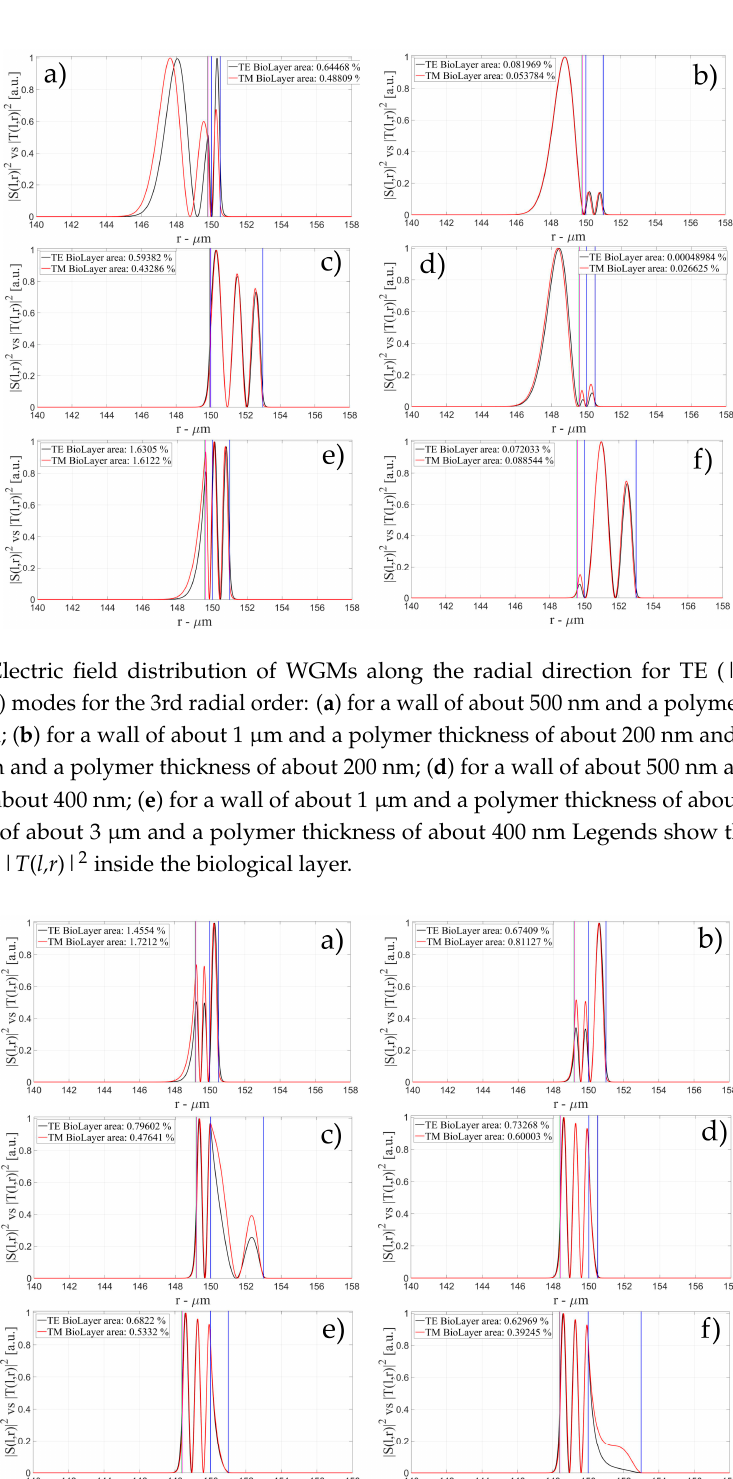
Figure 15. Electric field distribution of WGMs along the radial direction for TE (| S ( l,r ) | 2 ) and TM (| T ( l,r ) | 2 ) modes for the 3rd radial order: ( a ) for a wall of about 500 nm and a polymer thickness of about 800 nm; ( b ) for a wall of about 1 μ m and a polymer thickness of about 800 nm and ( c ) for a wall of about 3 μ m and a polymer thickness of about 800 nm; ( d ) for a wall of about 500 nm and a polymer thickness of about 1600 nm; ( e ) for a wall of about 1 μ m and a polymer thickness of about 1600 nm and ( f ) for a wall of about 3 μ m and a polymer thickness of about 1600 nm Legends show the fraction of | S ( l,r ) | 2 and | T ( l,r ) | 2 inside the biological layer.